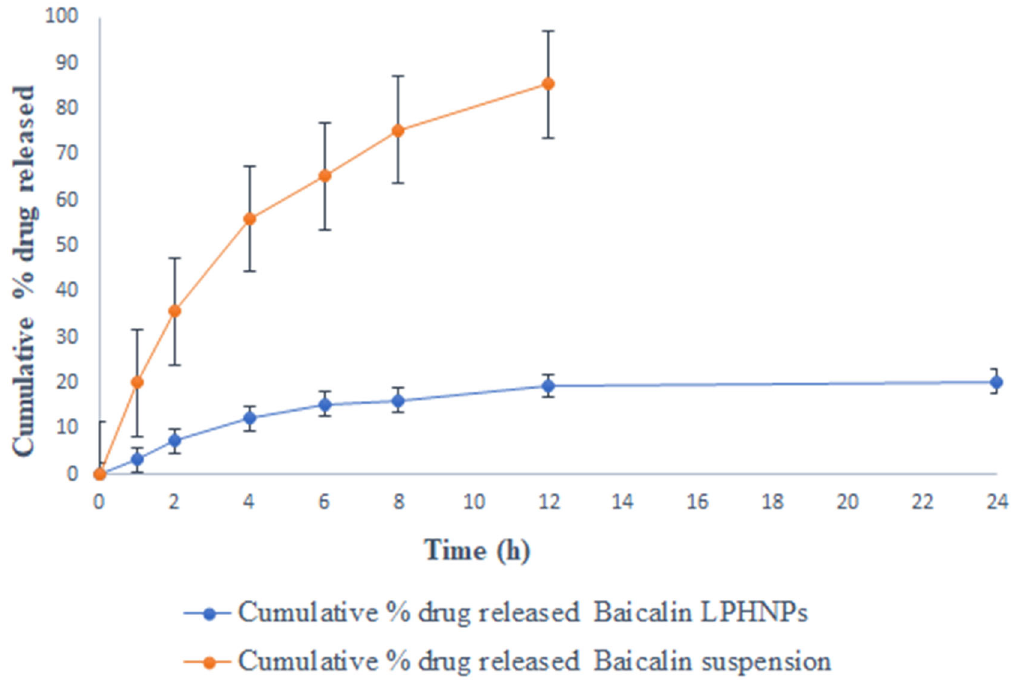
Figure 2. Percentage of in vitro release of baicalin-loaded LPHNPs in simulated gastric fluid (pH 1.2). Data expressed as mean ± SD (n = 6).